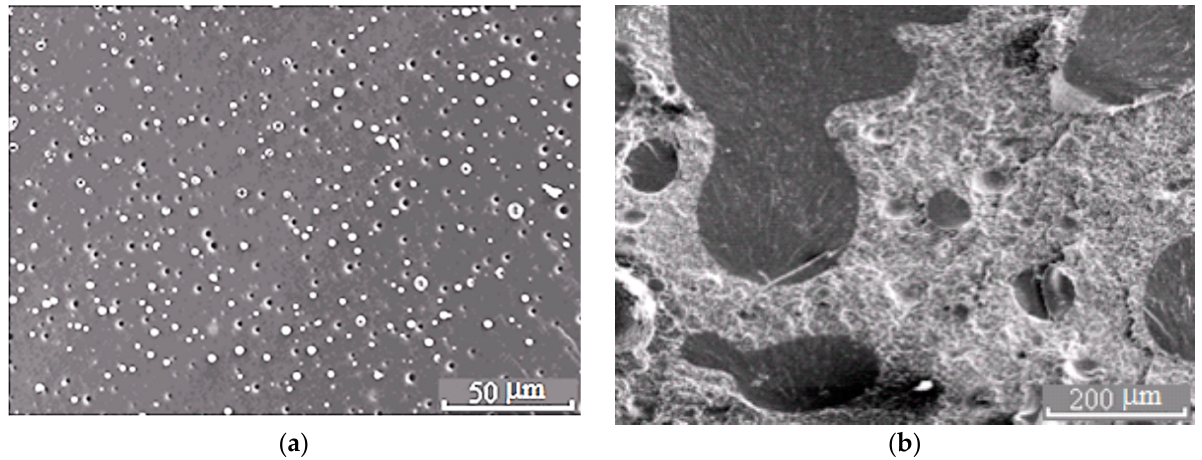
Figure 5. Morphology of the PSU–EO mixture at φ PSU 5 ( a ) and 15 wt.% ( b ).